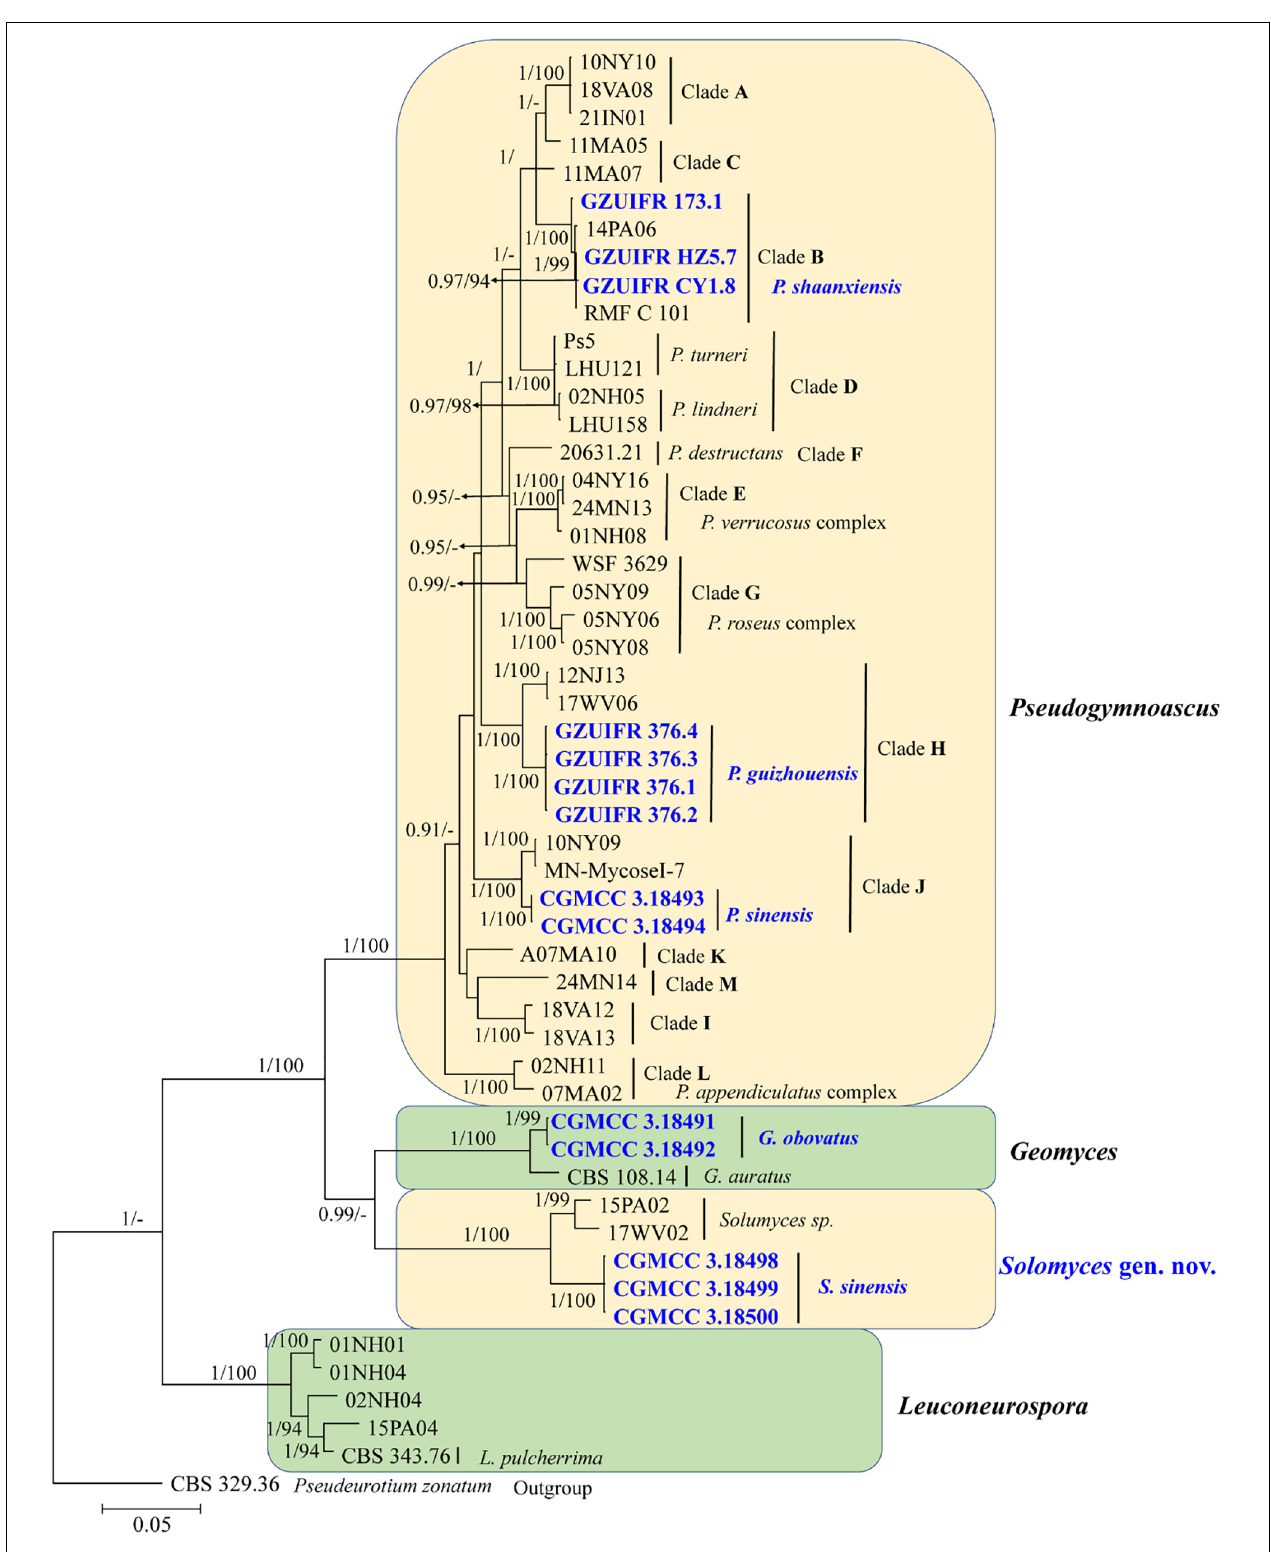
FIGURE 2 | The consensus tree from the Bayesian inference and Geomyces and its allied genera based on the ITS, LSU , MCM7 , RPB2 , and EF1A concatenated dataset. Posterior probabilities ≥ 0.7 and maximum-likelihood bootstrap values ≥ 90% are shown above the internal branches. The new isolates are presented in bold and